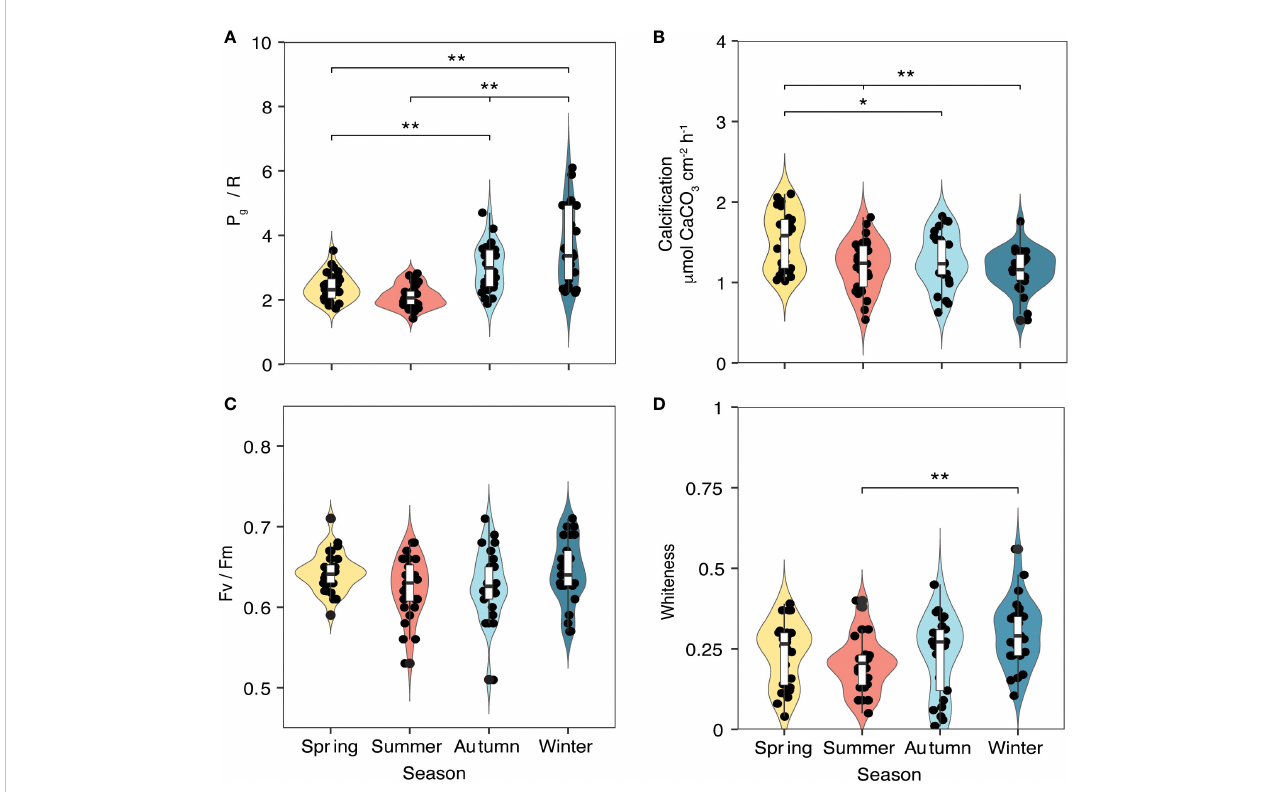
FIGURE 3 Metabolic parameters of P. carnosa corals (n = 5 per month) measured between April 2018 and March 2020 during daytime hours (between 10:30 am and 1:30 pm). (A) P g /R ratio and (B) calci fi cation (CA) were measured using a CISME device; (C) photosynthetic ef fi ciency (Fv/Fm) was measured in the same area of the coral using a diving Pulse Amplitude Modulated (PAM) fl uorometer; and (D) whiteness was calculated based on photographic analysis. Signi fi cance codes: ** p < 0.01; * p < 0.05; non-signi fi cant effects are not